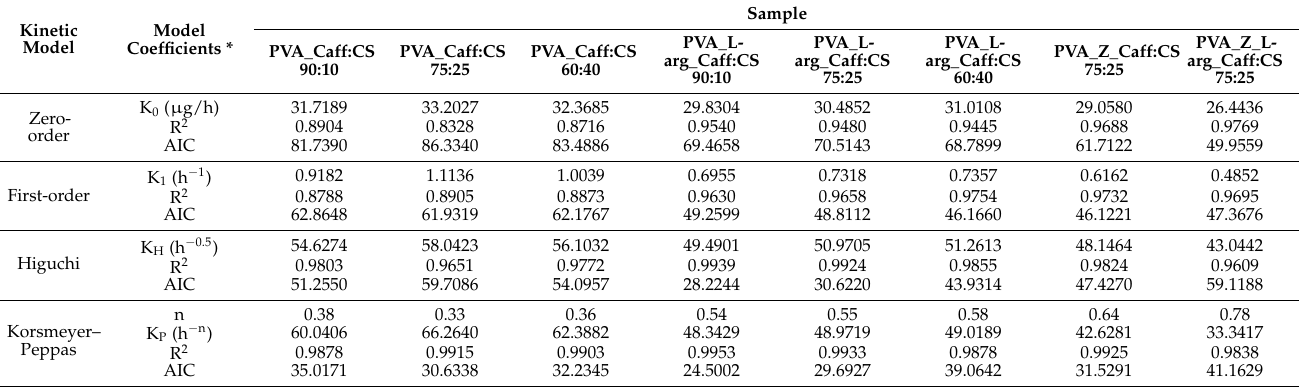
Table 3. Data fitting results of in vitro Caff release profile from